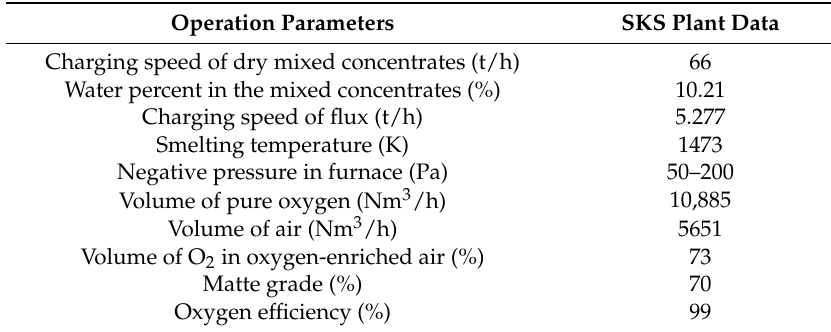
Table 5. Industrial operation parameters in the SKS process.